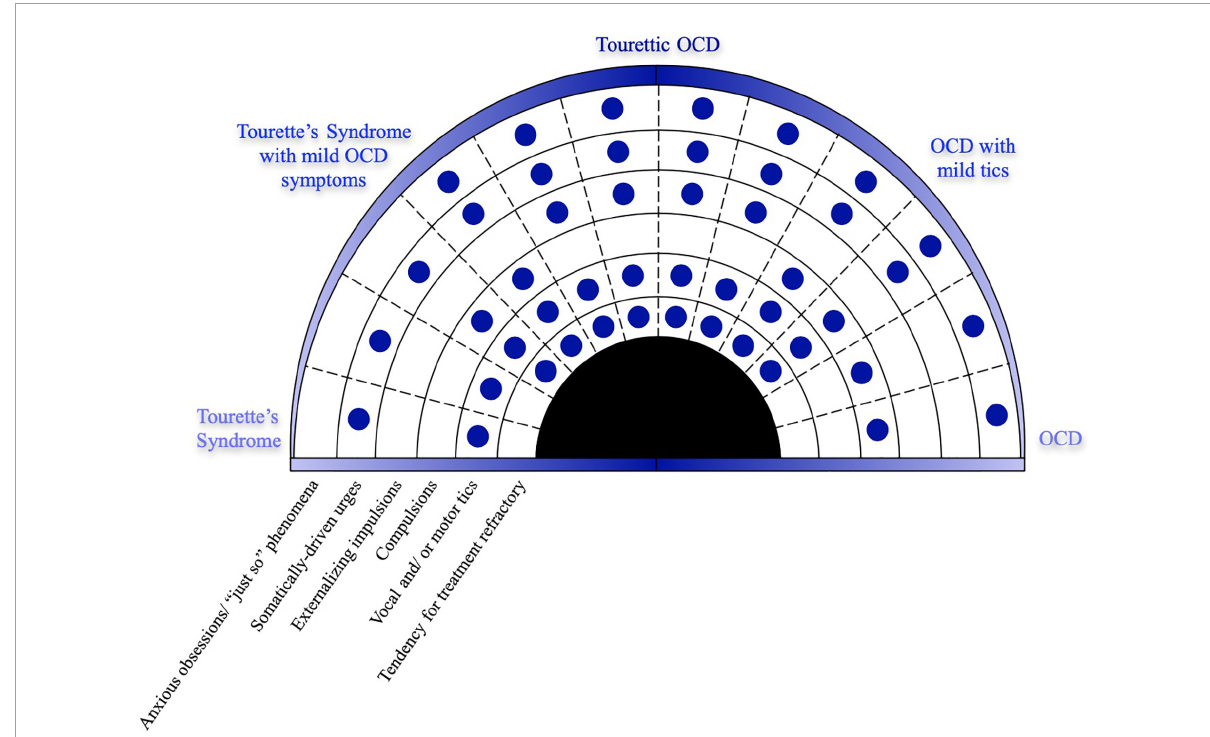
FIGURE4 TOCD may represent a unique endophenotype along a clinical spectrum of OCD and tic